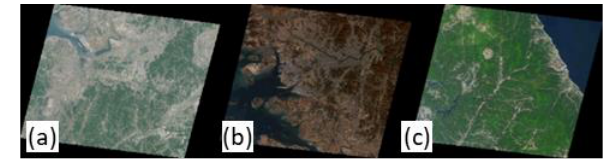
Figure 1. RapidEye images used. (a) Cheonan, (b) Incheon, (c) Yanggu.